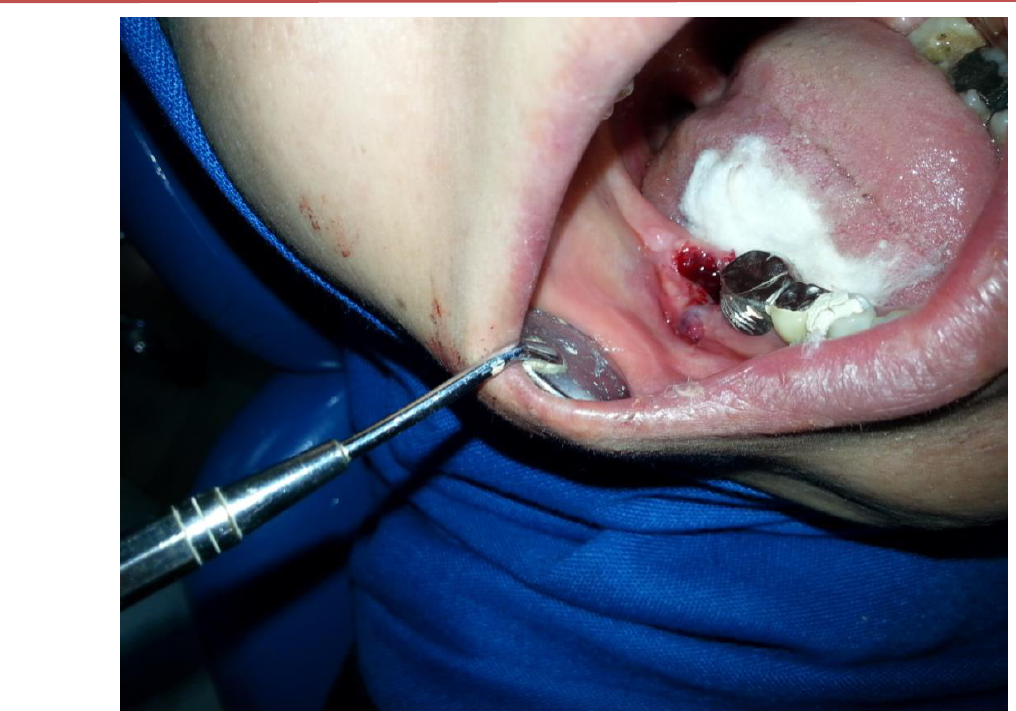
Figure (1): The tooth socket following the extraction of lower 2 nd molar tooth.